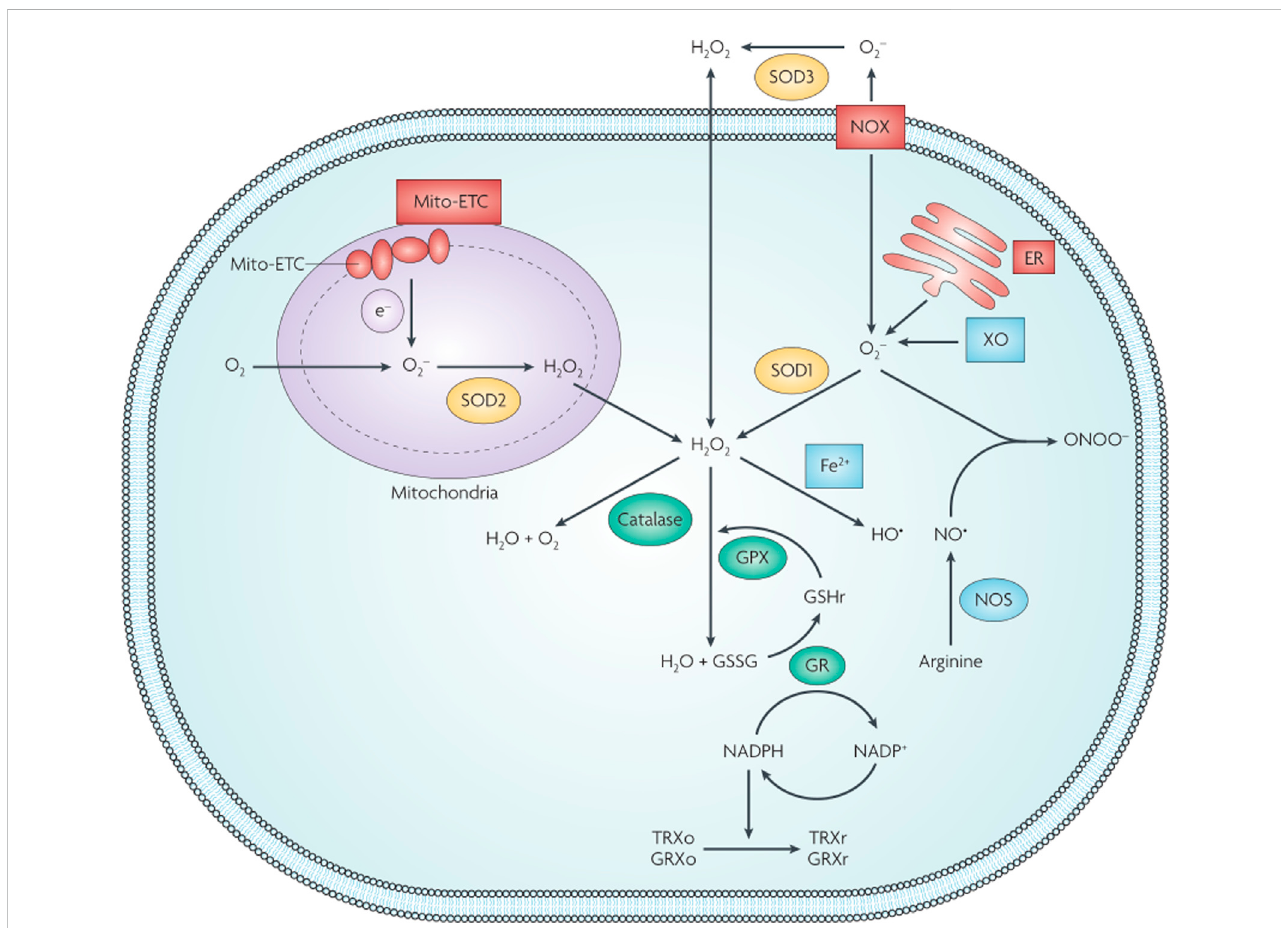
FIGURE 5 Schematic illustration of cellular redox homeostasis. GPX, glutathione peroxidase; GR, glutathione reductase; GRXo, glutaredoxin (oxidized); GRXr, glutaredoxin (reduced); GSHr, glutathione (reduced); GSSG, glutathione (oxidized); TRXo, thioredoxin (oxidized); TRXr, thioredoxin (reduced); XO, xanthine oxidase. Reproduced with permission from (Trachootham et al., 2009) Copyright (2009) Nature